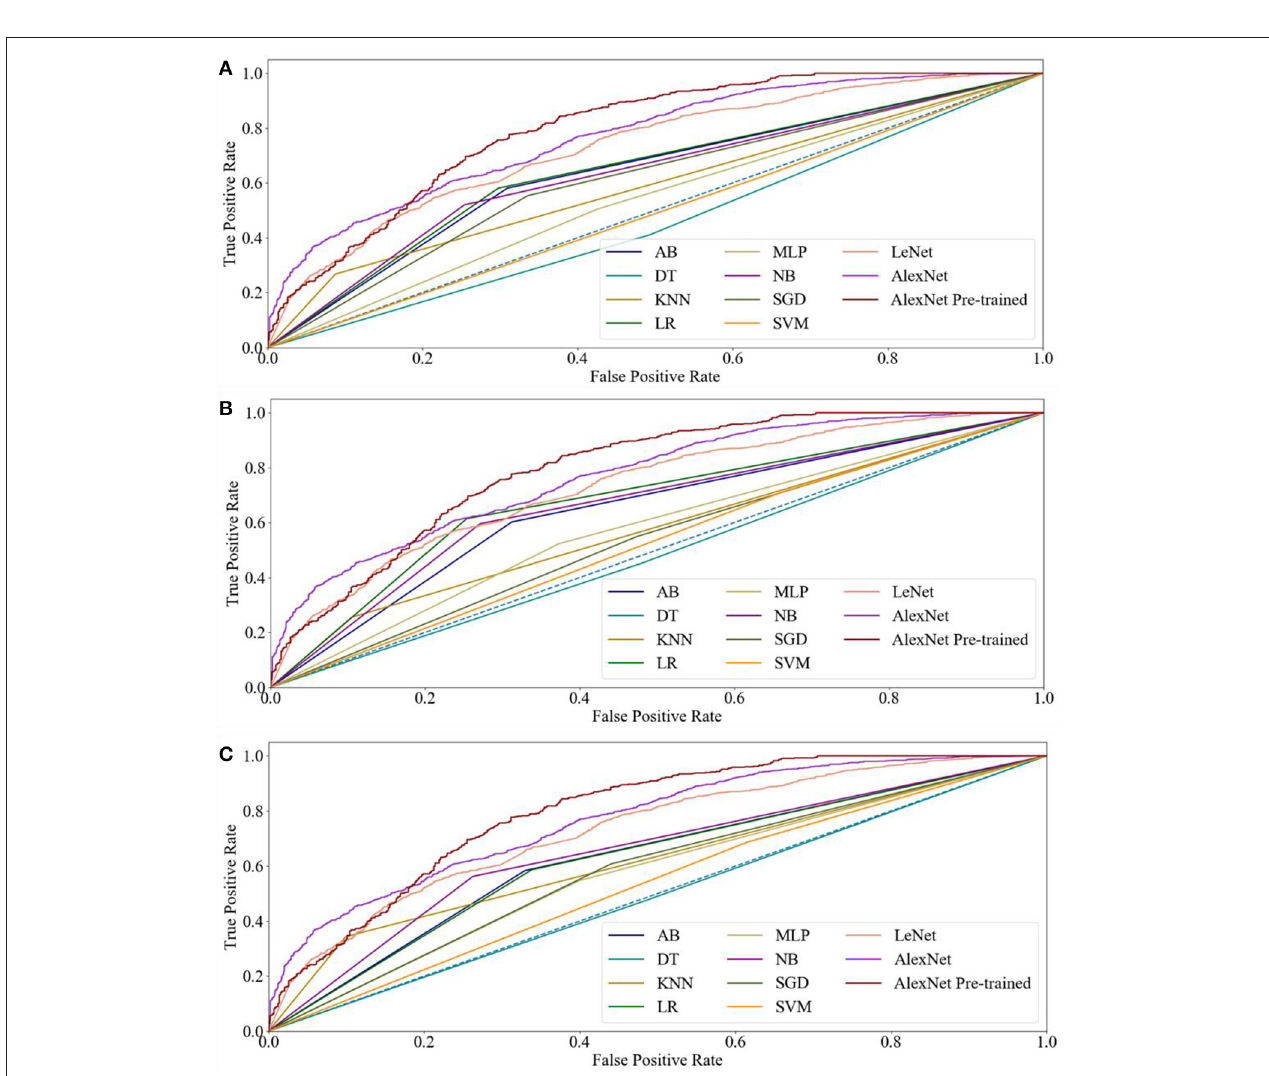
FIGURE 3 | Receiver operating characteristic curves of all methods for CRC LNM: (A) ML with GLH and CNN, (B) ML with GLCM and CNN, and (C) ML with SIFT and CNN.